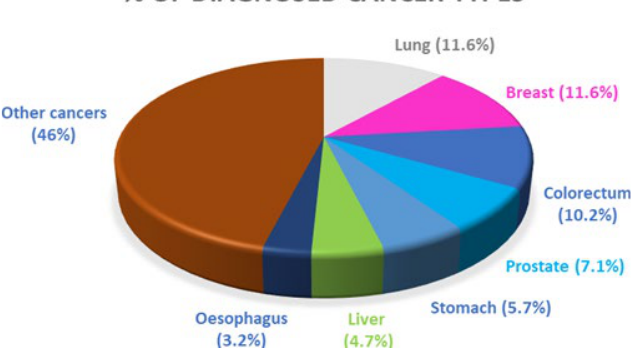
Figure 1. Percentage of each diagnosed cancer type. Data from the International Agency for Research Cancer, World Health Organization.